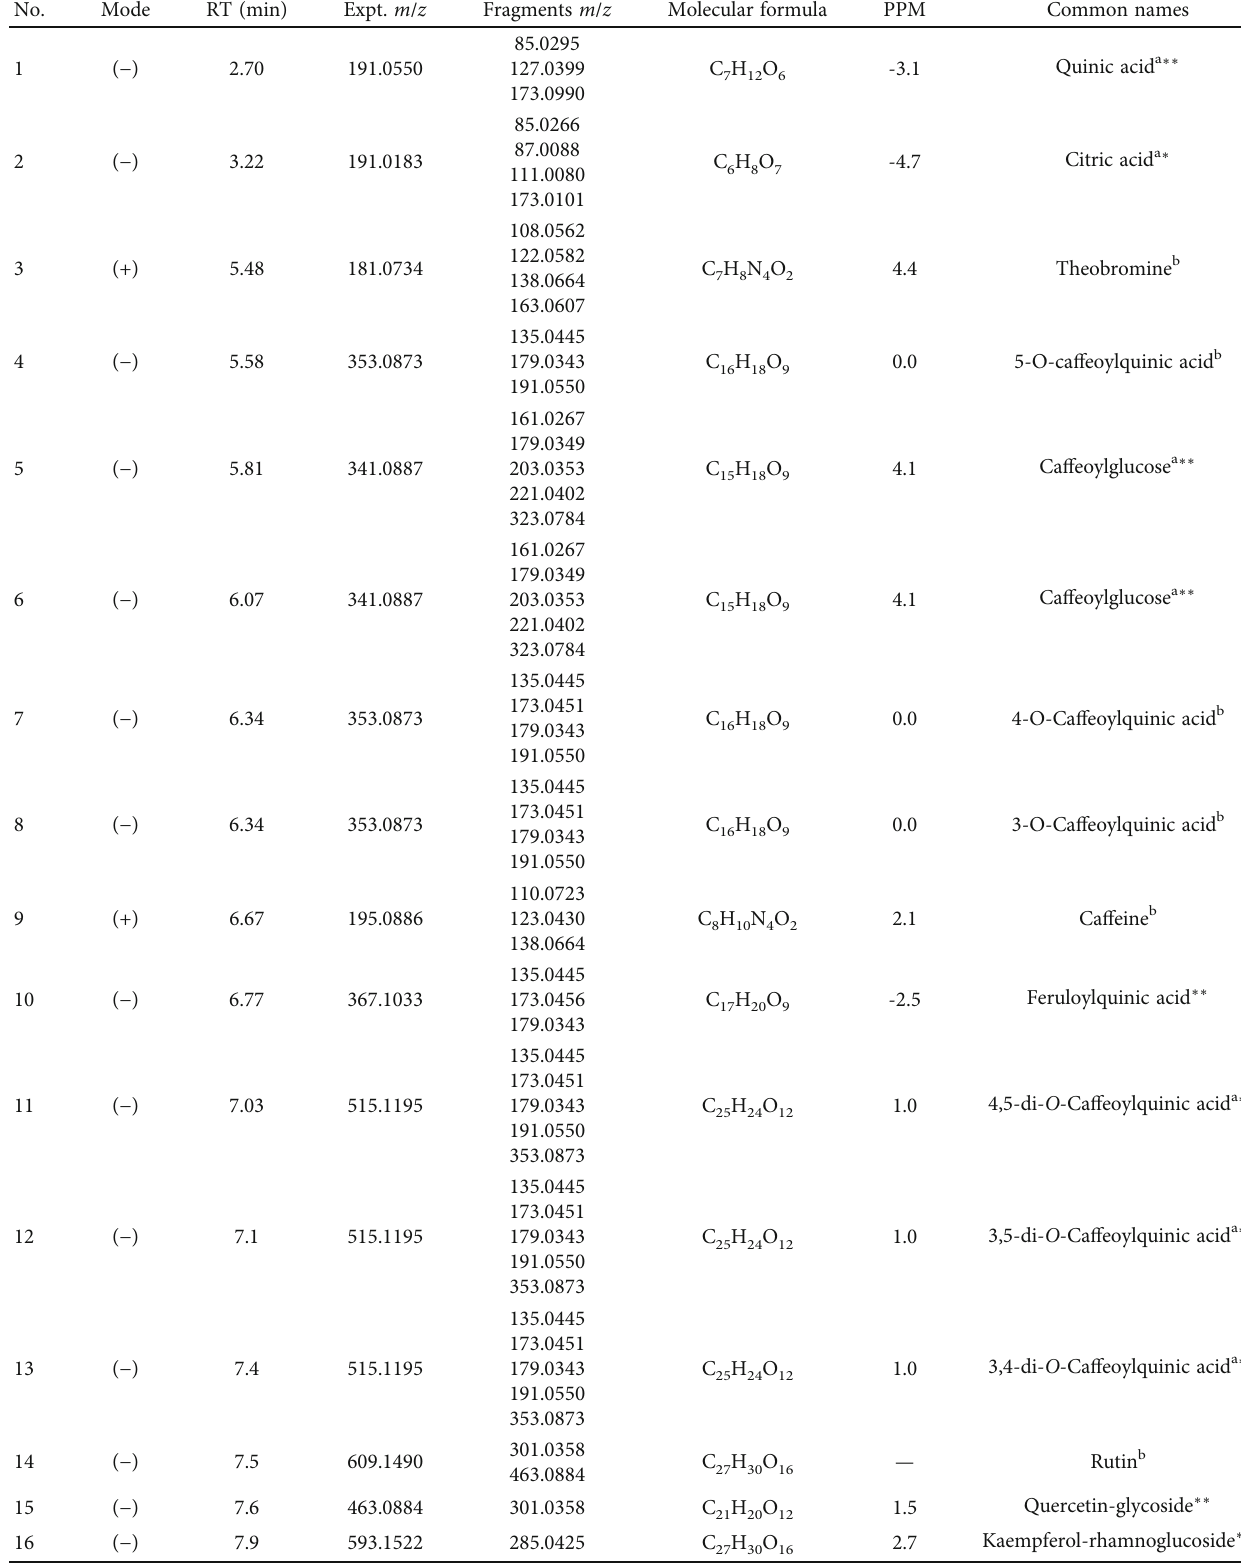
Table 2: Characterization of the major phytoconstituents of Ilex paraguariensis by